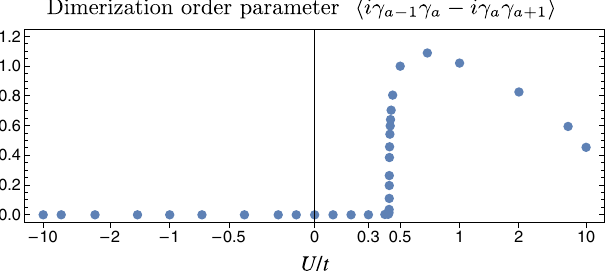
γ − i γ γ ver- a − 1 a a a þ 1 i FIG. 5. (a) Snapshot of domain-wall excitations at the exactly solvable, spontaneously dimerized limit of Eq. (20) occurring for t 0 ¼ 0 and U ¼ t= 2 . Neighboring sites a , a þ 1 enclosed by curved rectangles dimerize such that h γ walls at which the dimerization pattern shifts by one site trap unpaired Majorana zero modes [nonenclosed dots in (a)]. In the low-energy limit, the dimerized chain is described at the mean- field level by Eq. (18), which includes a spontaneously generated mass m . Microscopic domain-wall excitations from (a) corre- spond in continuum language to excitations at which the mass m changes sign, as depicted in (b). Such domain walls constitute 1D analogs of Ising anyons that arise at the spontaneously gapped spin-liquid interface of Fig.